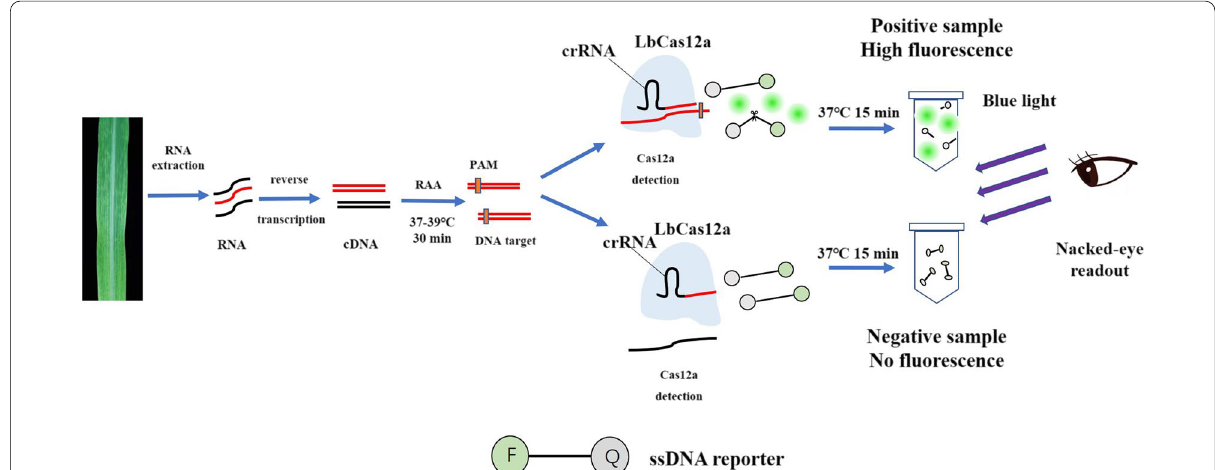
Fig. 1 Schematic diagram of the method for rapid and visual nucleic acid detection using RT-RAA-CRISPR/Cas12a assay. In this detection system, target gene fragments were amplified with RAA procedure; ssDNA probes (5 ′ -FAM/3 ′ -BHQ1 labeled) were added, and subsequently cleaved by Cas12a to generate green fluorescence; the detection results were visible to the naked eye under blue